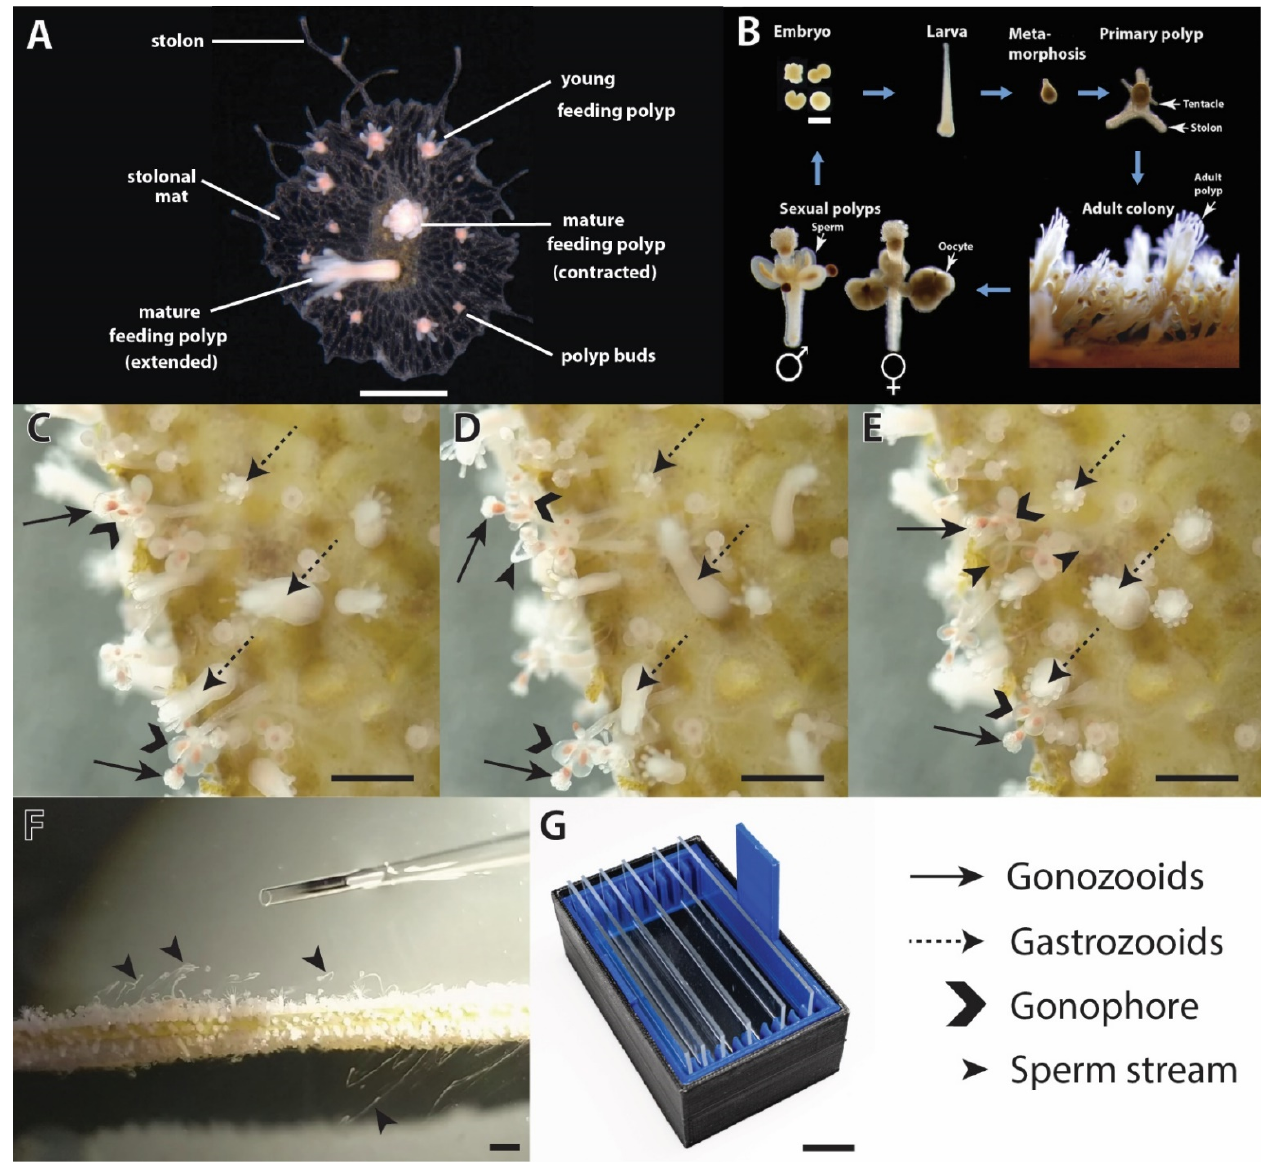
Figure 1. Hydractinia colony morphology, life history, and sperm release and collection. ( A ) Major morphological structures of a colony (scale bar = 1 mm). ( B ) Life cycle (scale bar = 200 μ m). ( C ) Polyps directly prior to sperm release (scale bar = 2 mm). ( D ) Polyps during sperm release (scale bar = 2 mm). ( E ) Polyps during late stages of sperm release and polyp retraction (scale bar = 2 mm). ( F ) Collection of sperm streams by use of pipet (scale bar = 2 mm). ( G ) The 3-D printed Hydractinia sperm collection chamber (black) with the slide rack (blue) inserted with slides (scale bar = 1.9 cm). Panels ( A , B ) are adapted from [4,16] and licensed under CC BY 4.0 (link: https://creativecom- mons.org/licenses/by/4.0, accessed on 21 September 2022).